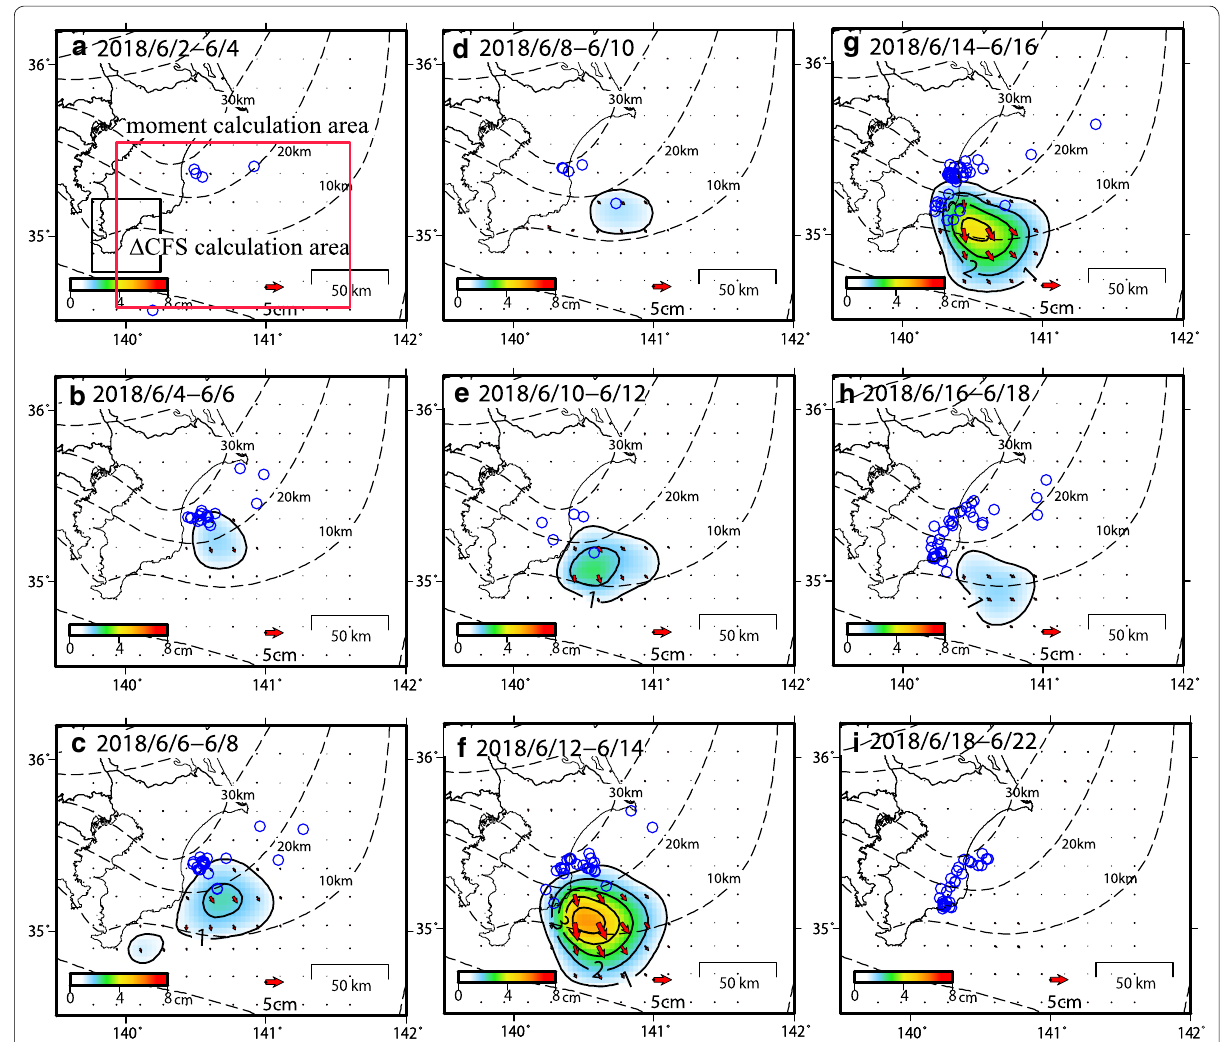
Fig. 3 a Estimated aseismic slip per 2 days on the interface between the CJP and the Philippine Sea plate for the period between June 2, 2018, and June 4, 2018, with a contour interval of 1 cm/2 days. The color shows the magnitude of slippage, while the arrows show slip vectors. The dashed lines indicate isodepth contours of the plate interface with an interval of 10 km. Blue circles indicate the hypocenters of earthquakes within 5 km from the plate interface for the corresponding period. The black rectangle shows the area where ΔCFS is calculated. The red rectangle shows the area of the moment calculation. b – i Estimated aseismic slip for various periods. b June 4, 2018–June 6, 2018. c June 6, 2018–June 8, 2018. d June 8, 2018–June 10, 2018. e June 10, 2018–June 12, 2018. f June 12, 2018–June 14, 2018. g June 14, 2018–June 16, 2018. h June 16, 2018–June 18, 2018.